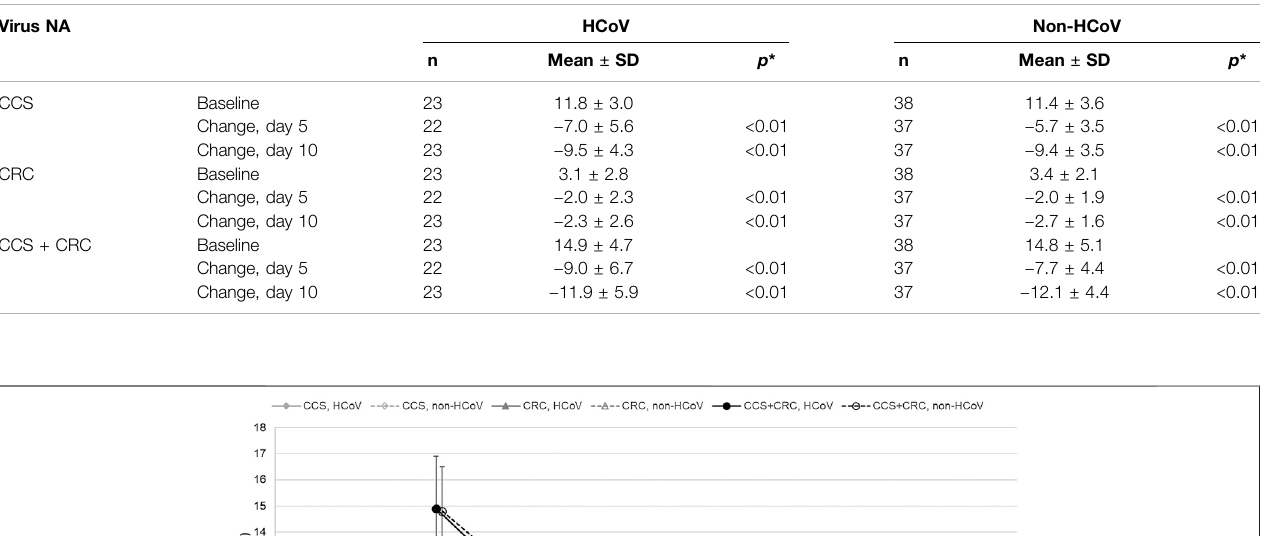
TABLE 2 | Common cold associated symptoms – baseline total score and change between baseline and subsequent visits (CCS, common cold symptoms; CRC, further common cold relevant complaints; CCS + CRC, overall symptom score; investigator ratings, mean ± SD and Wilcoxon test for change vs. baseline; FAS; *two-sided p -value of Wilcoxon signed rank test).